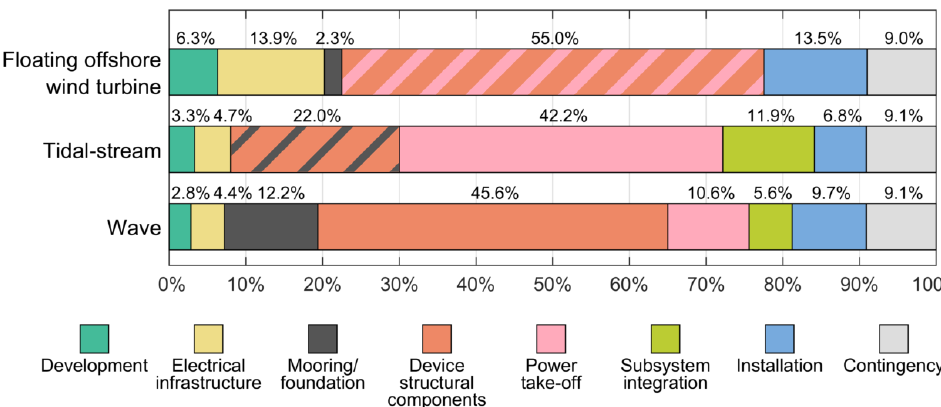
Figure 4. Commercial scale CAPEX breakdowns by subsystem used as inputs to case studies. Note that some subsystems are combined in the source data, shown by hatched bars.